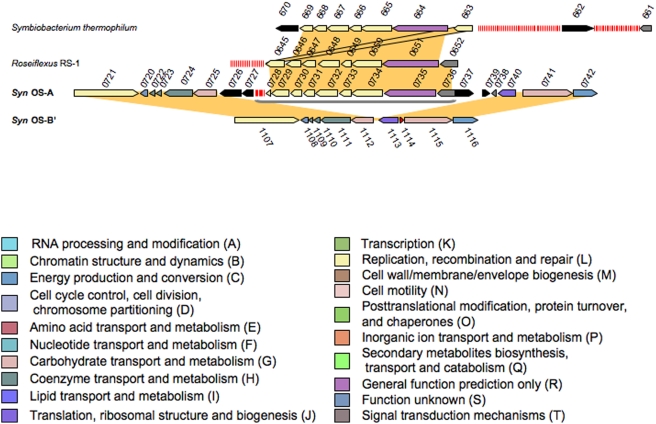
Comparison of Type III CRISPR locus to Roseiflexus RS-1 and Symbiobacterium.
Homologous regions from Syn OS-A, Syn-OS-B′, Roseiflexus RS-1 and Symbiobacterium are displayed. Gene identifiers are shown above or below each gene, excluding the GenBank locus tag prefix ‘CYA_’ (for Syn OS-A), ‘CYB_’ (for Syn OS-B′), RoseRS_ (for Roseiflexus RS-1) or STH (for Symbiobacterium thermophilum). Additional figure conventions are as described in Figure 2. Details about the genes can be found in Table S3.